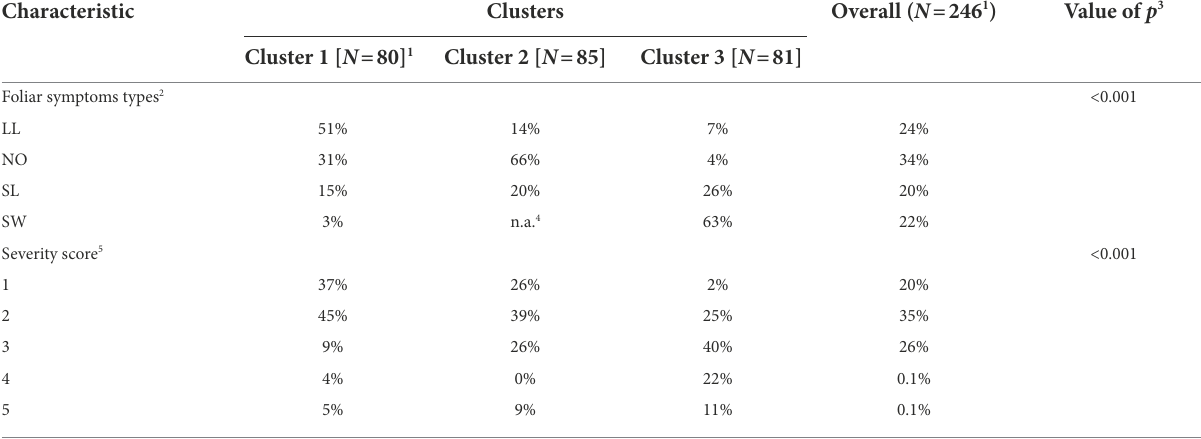
TABLE 6 Types and severity of foliar symptoms observed on surveyed plants across clusters. Characteristic